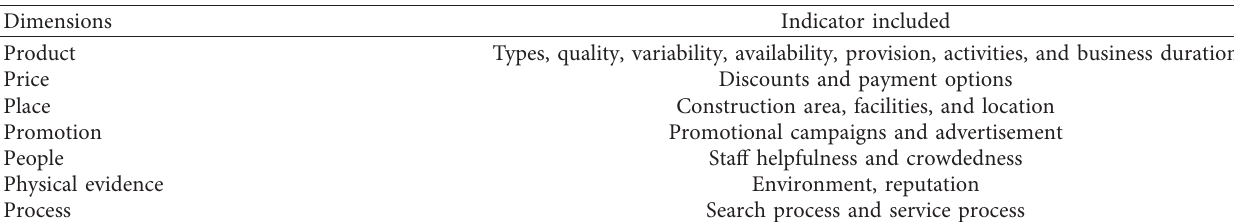
Figure 3: Explanation of the study range based on walking distance, using the example of Zhonglou Station on ML #2. Table 1: Overview in commercial property attractiveness-related indicators [14].